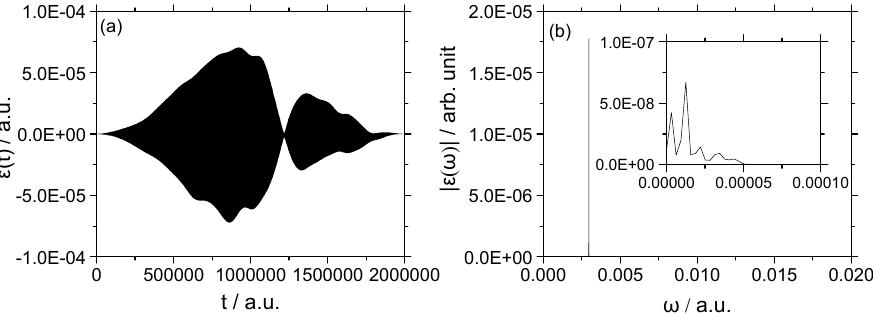
Figure 6. ( a ) The optimal field ε ( t ) for the vibrational–rotational excitation, ( v = 0, J = 0) → ( v = 1, J = 2), in the weak-field regime; ( b ) the spectrum of ε ( t ).